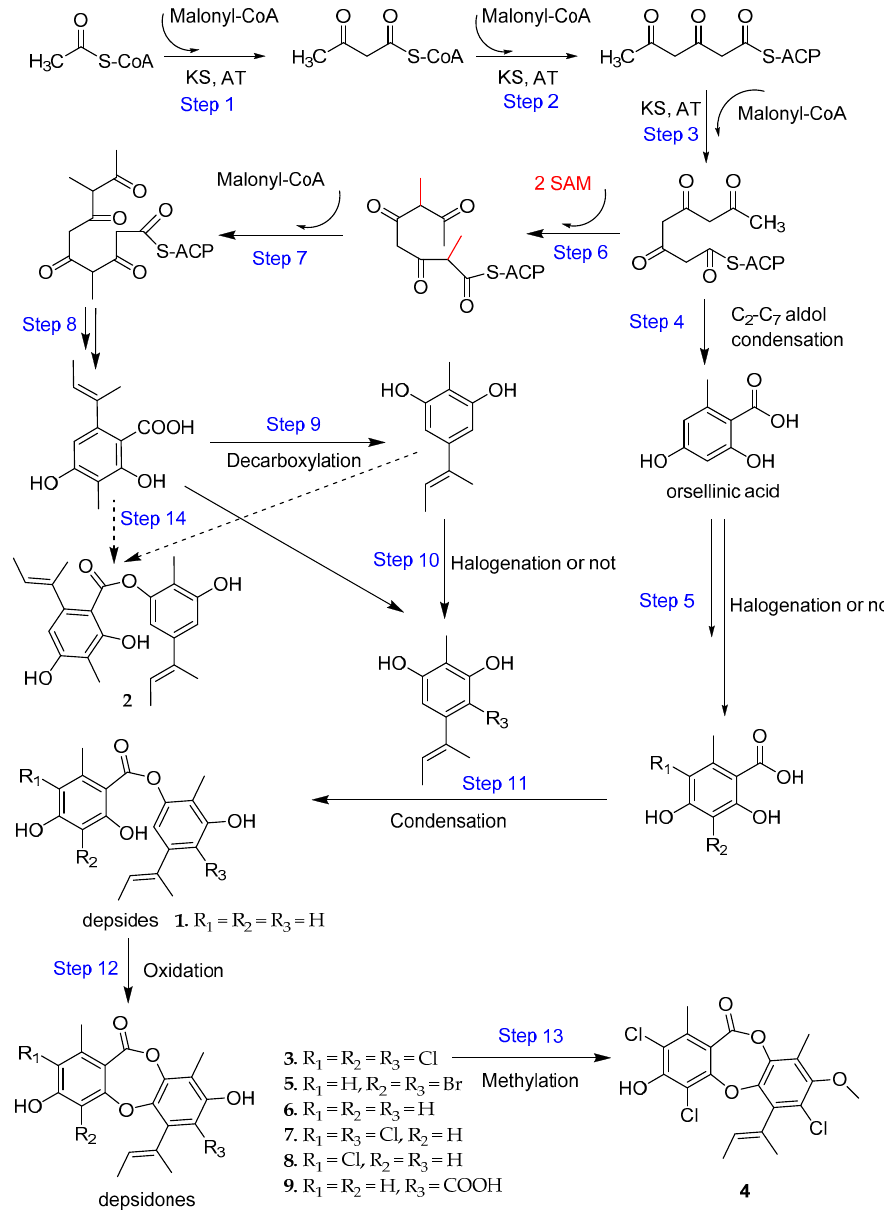
Figure 4. Probable proposed biosynthetic pathways for depsides 1 – 2 and depsidones 3 – 9 , KS, ketosynthase; AT, acytransferase; ACP, acyl carrier protein; SAM, S-Adenosyl methionione [19,26 ‒ 28].